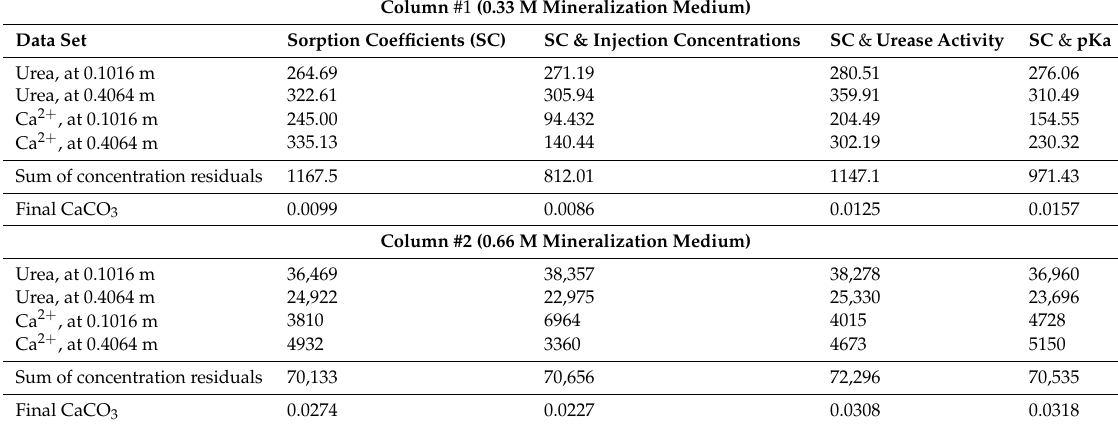
Table 3. Residuals for the data sets of the concentrations of urea and Ca 2 + concentrations in g 2 / L 2